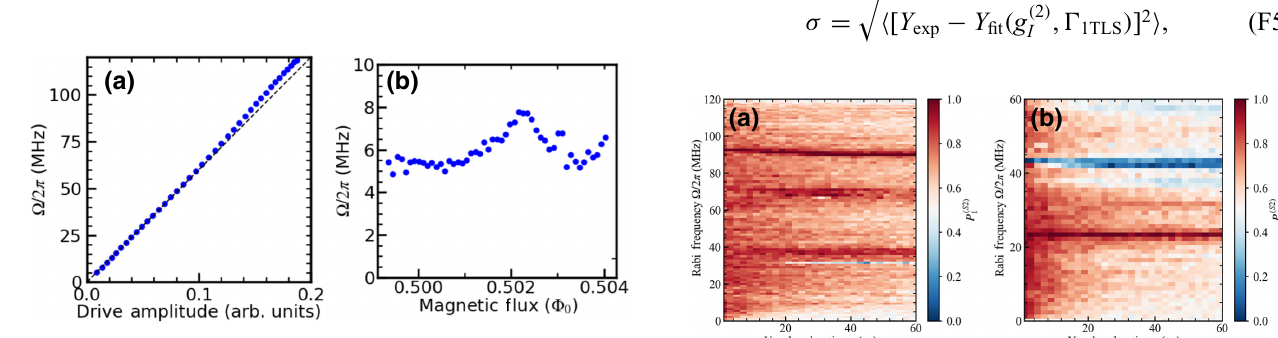
FIG. 11. Typical results of spin-locking measurements using the modified pulse-sequence (sequence 2) at the (a) optimal flux bias point 0.5 (cid:5) 0 and (b) flux bias 0.5039 (cid:5) 0 . The qubit is initialized in the | i −(cid:7) state in the rotating